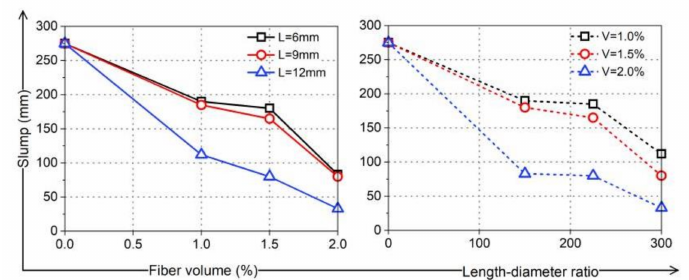
Figure 3. The slump of fresh coral cement-based